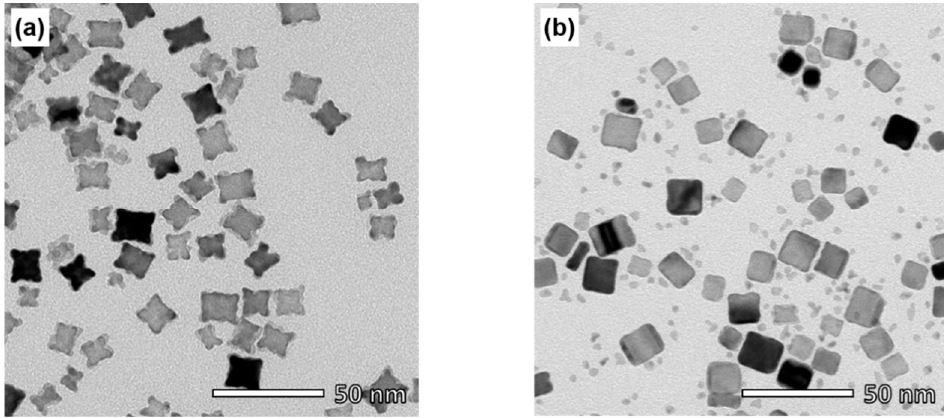
Figure 4. TEM images of nanocubes synthesized ( a ) using L-ascorbic acid (AA) as reducing agent instead of citric acid (CA) and ( b ) F-PdPt 20 .